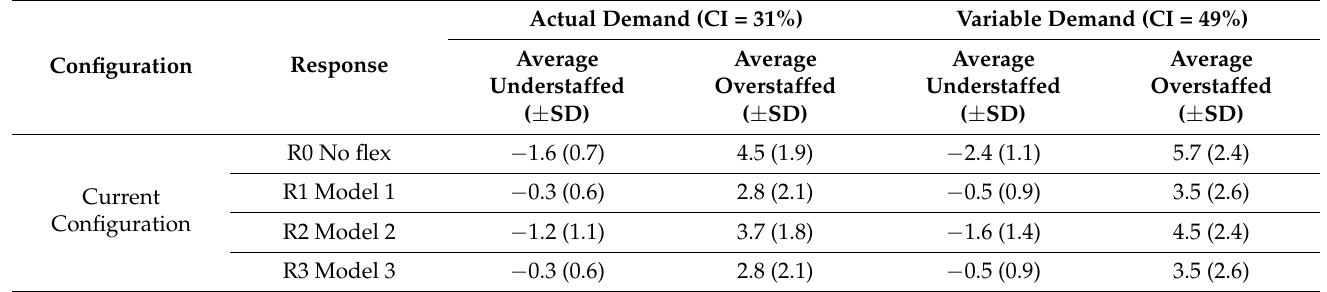
Table 8. Results of simulation with the current care system configurations using the actual demand and variable